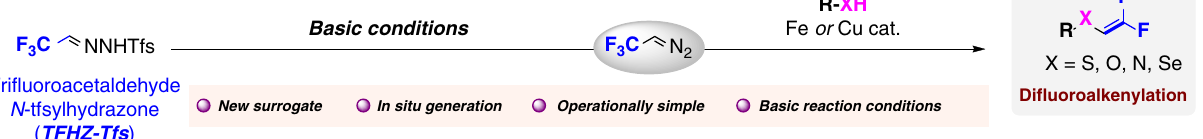
Fig. 1 Generation and transformations of tri fl uorodiazoethane, and synthesis of TFHZ-Tfs. a Synthesis and applications of tri fl uoromethyldiazomethane (CF 3 CHN 2 ) in organic synthesis. CF 3 CHN 2 is a highly reactive tri fl uoroalkylation reagent, but its simplex synthesis method, inherent toxicity and explosiveness limit its widespread application. Because of its hazardous nature, manifold methods have been developed for the safer use of CF 3 CHN 2 such as slow addition of oxidants, small-scale preparation of CF 3 CHN 2 solution, recycling of gaseous CF 3 CHN 2 and continuous- fl ow chemistry. b Method for the generation of CF 3 CHN 2 from tri fl uoroacetaldehyde N-tfsylhydrazone under basic condition and gem -di fl uoroalkenylation of X –